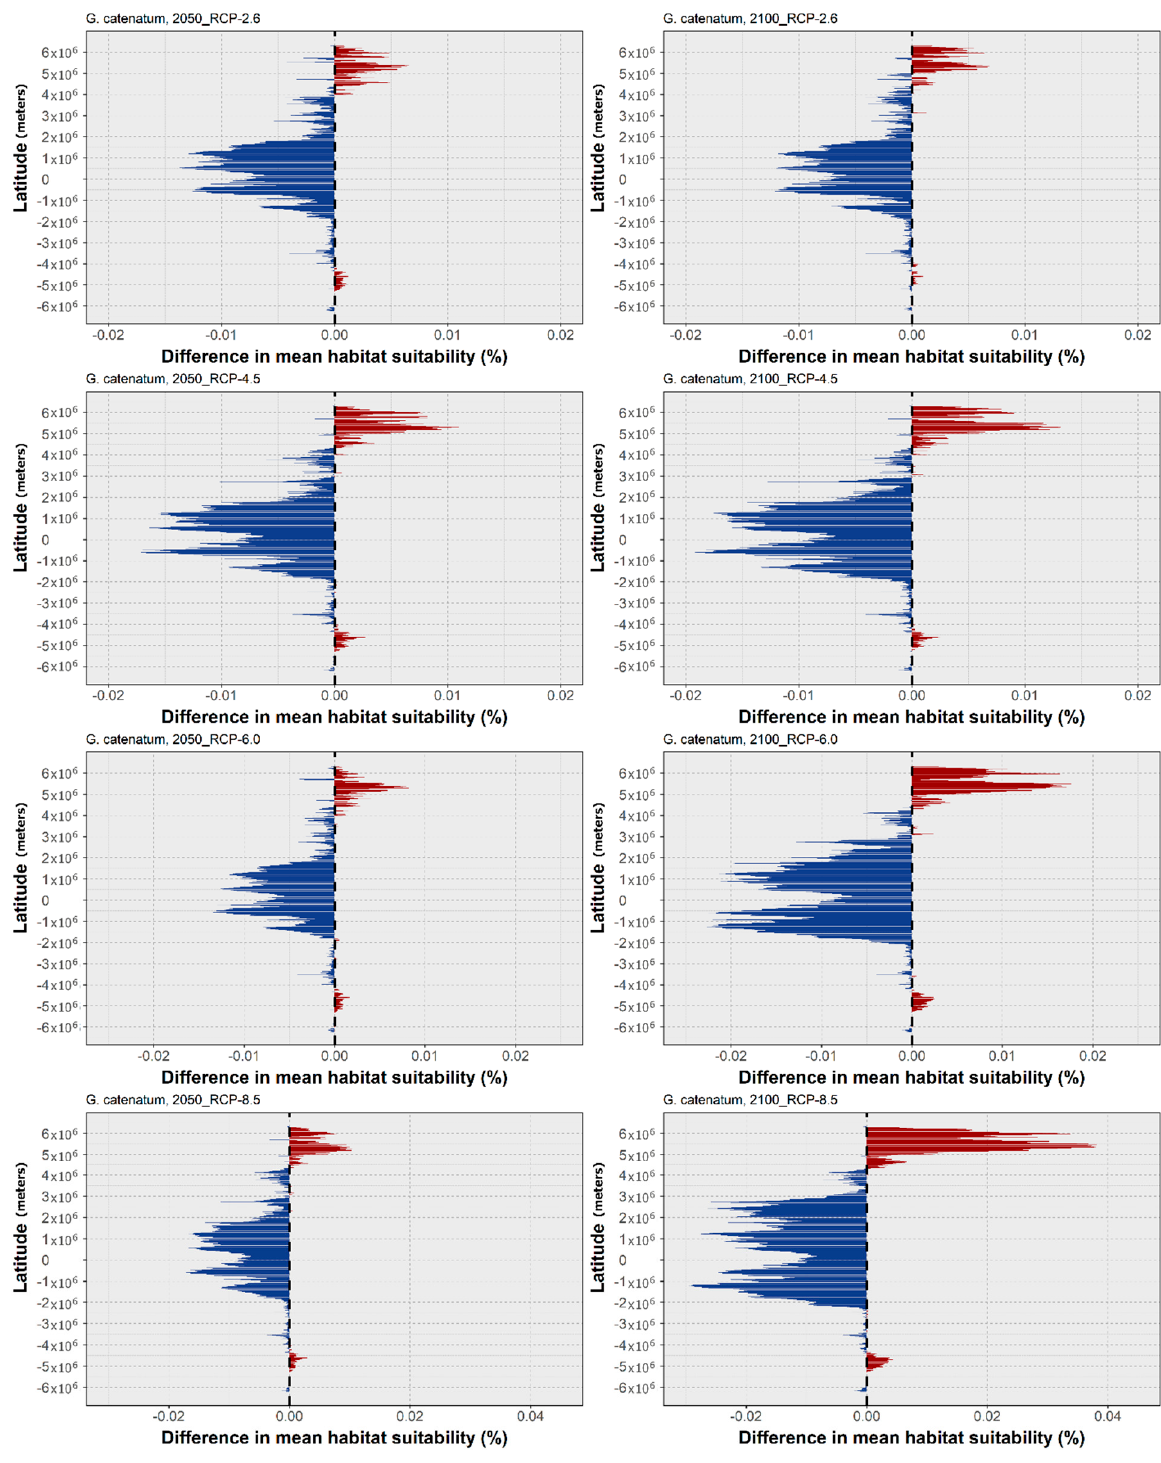
Figure 6. Projected changes in mean latitudinal habitat suitability for G. catenatum between the present-day and 2050 ( left side ) and 2100 ( right side ), for each Representative Concentration Pathway scenario (RCP-2.6, 4.5, 6.0, 8.5; CMIP5), relative to the present-day baseline (i.e., the black dashed vertical line). Data to the right of the dashed line represents gains (red) and data to the left represents losses in mean habitat suitability (blue).